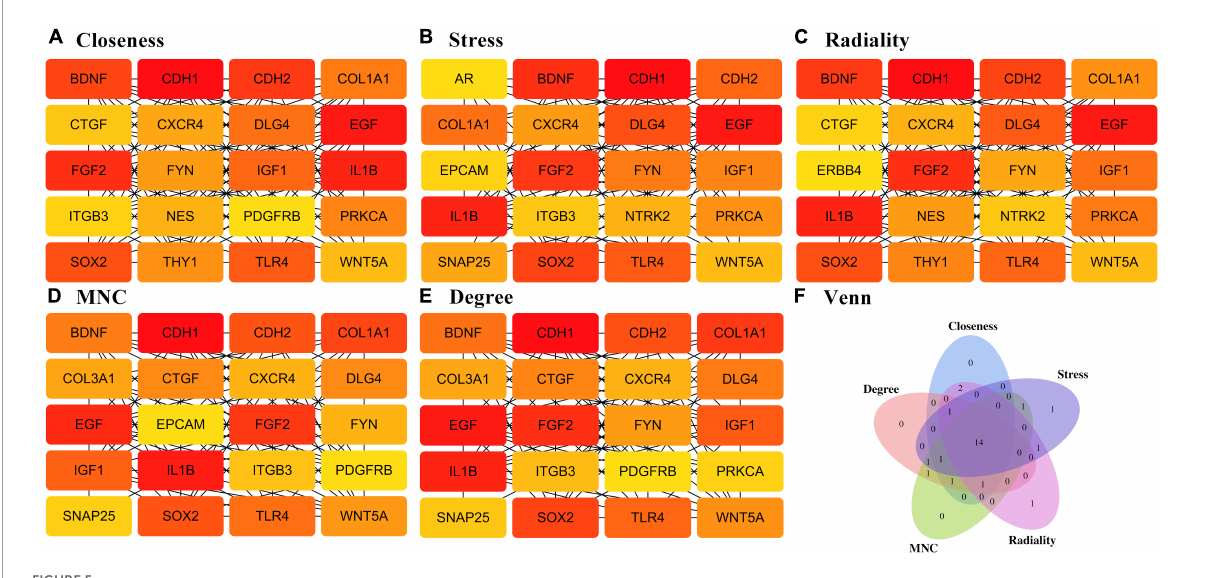
FIGURE5 PPI network based on DEGs. (A–E) Different algorithms for interaction analysis of the top 20 pivotal genes. (F) Wayne diagram showing the 14-hub gene intersected by different algorithms.